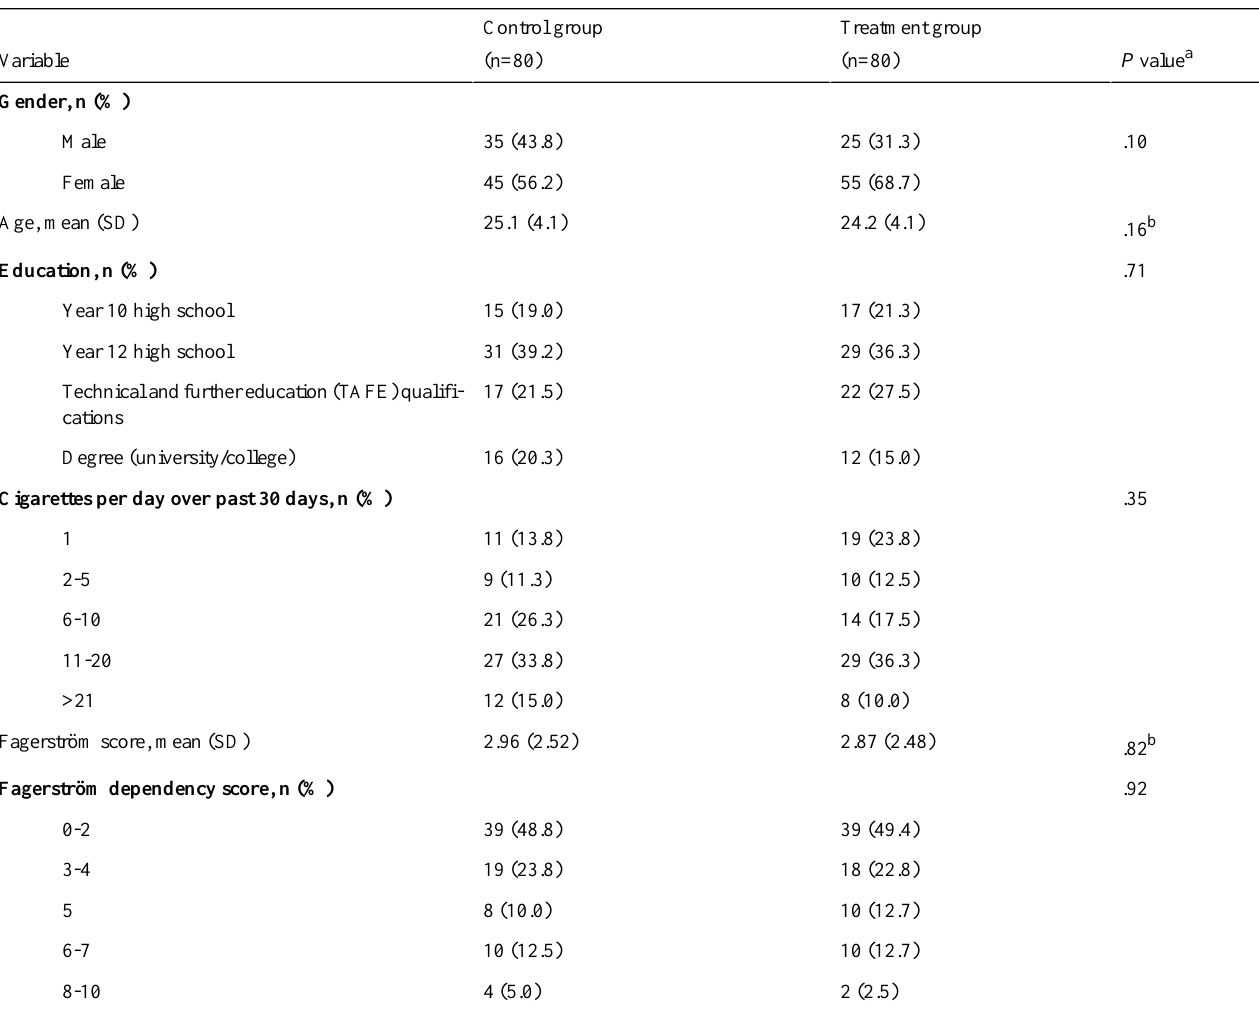
Table 2. Demographic and baseline smoking profile of study participants